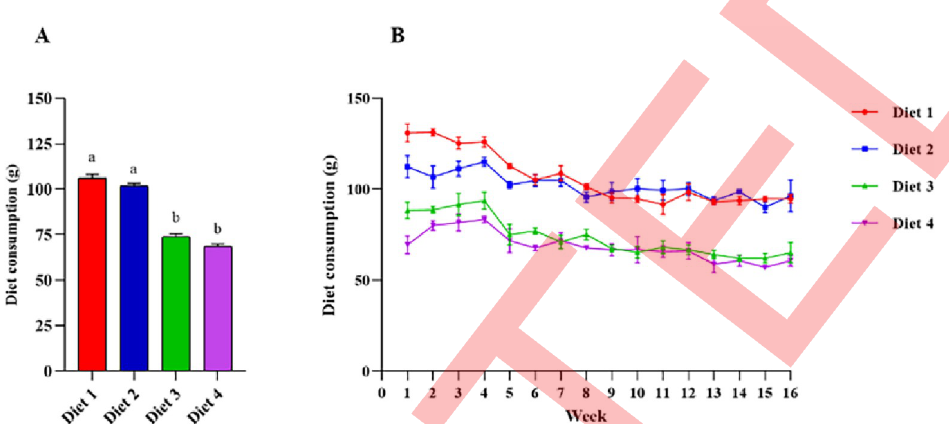
Fig 1. Mean weight (g) of supplement diet consumed by honey bee colonies in each treatment. (A), the maximum weight (shows as mean ± standard error) of diet consumption by honeybee colonies over the time of observation. (B), the maximum weight (shows as mean ± standard error) of various diets consumed by honey bee colony per week. The different small letter within each data represents statistically significant differences (p < 0.05).